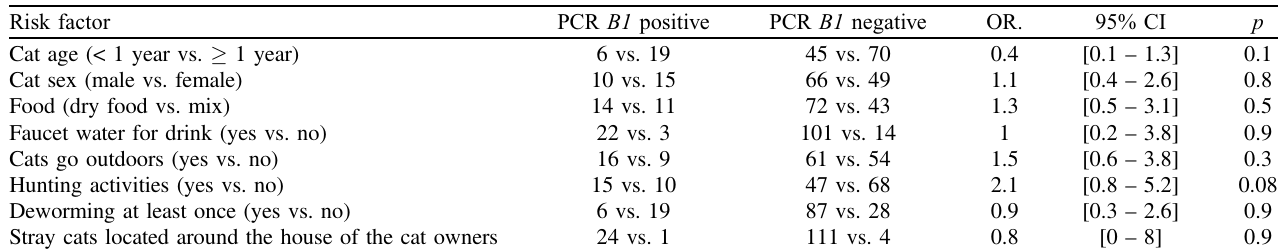
Table 3. Relationship between demographic, behavioral and cat care variables and presence of T. gondii DNA in fecal samples. Risk factor PCR B1 positive PCR B1